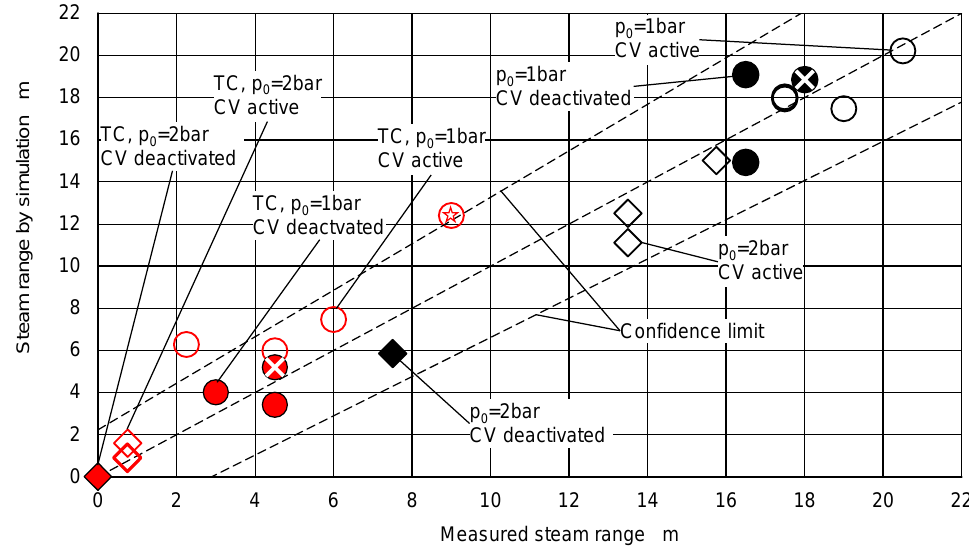
Figure 10. Comparison of total steam ranges from experimental data and simulations for the system with thermochromic absorbers (red) and conventional selective absorbers (black). Markers with white crosses correspond to the dataset 08−16. The marker with a red star corresponds to the dataset 07−25.